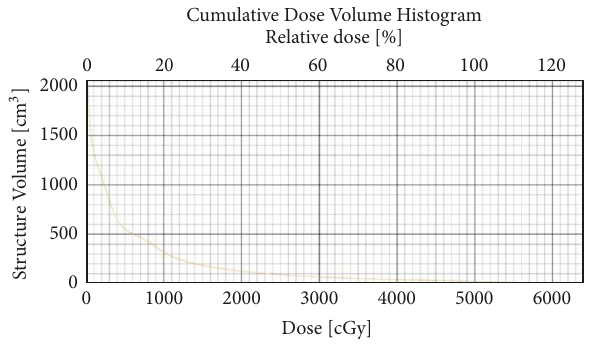
Figure 2: DVH showing total lung minus target dose for patient